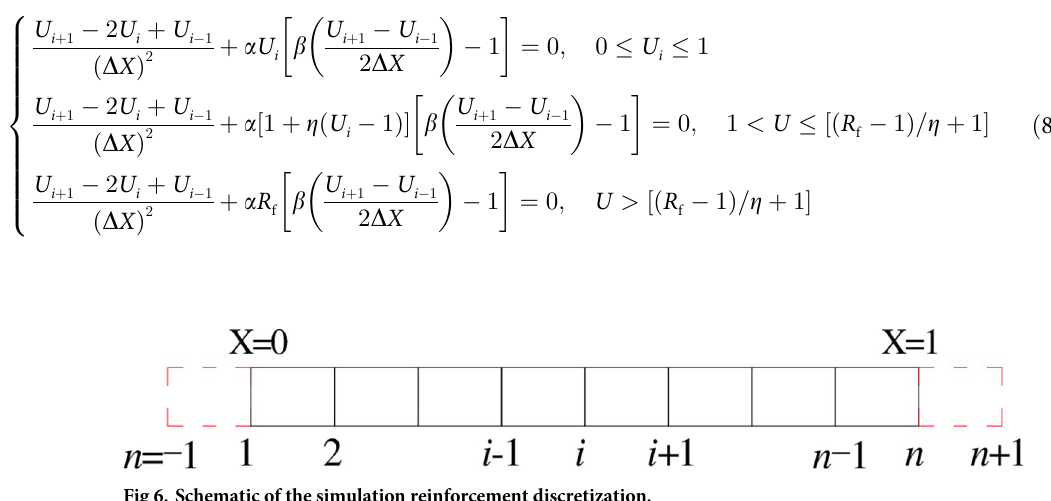
Fig 6. Schematic of the simulation reinforcement